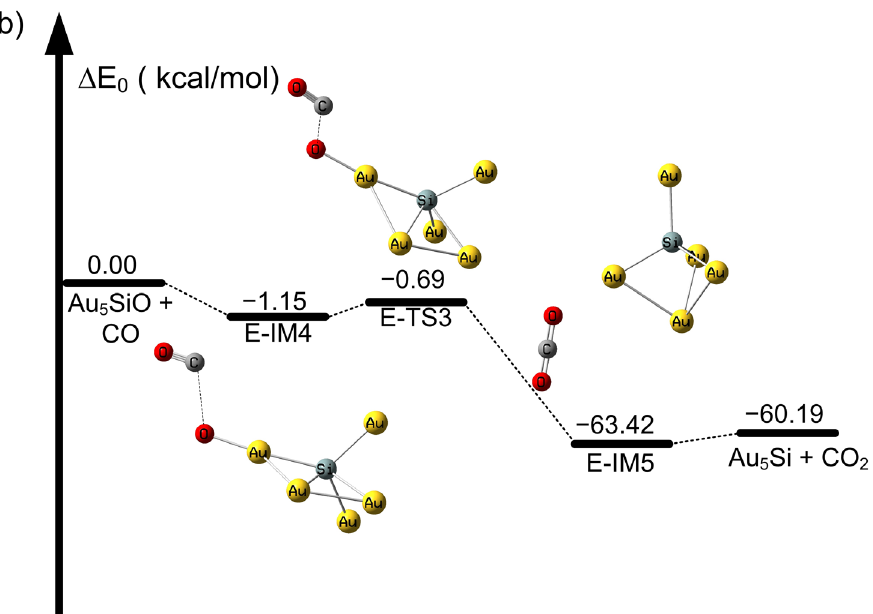
Figure 6. Potential energy profile of CO oxidation on SiAu 5 atoms at the CAM-B3LYP/aug-cc-pVDZ- PP level. ( a ) Oxidation of CO on the Au 5 Si cluster and ( b ) oxidation of CO on the OSiAu 5 cluster (in kcal/mol).